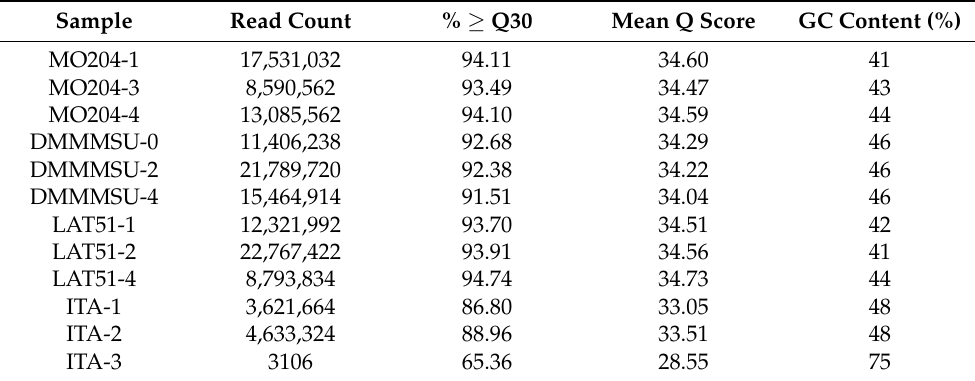
Table 3. Statistics of raw RNA-seq read sequences of Bombyx mori